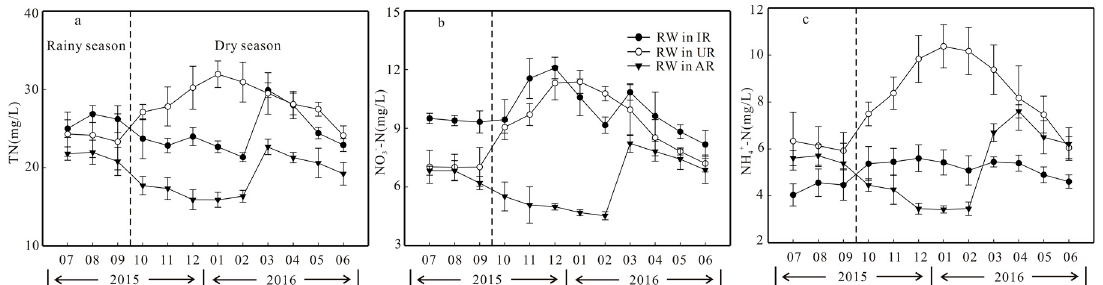
Figure 3. Temporal variation in ( a ) total nitrogen (TN), ( b ) NO 3- –N, and ( c ) NH 4+ –N concentrations in the lower reach of Fenhe River. The error bars represent standard deviation. RW in IR: river water in industrial region; RW in UR: river water in urban region; RW in AR: river water in agricultural region.